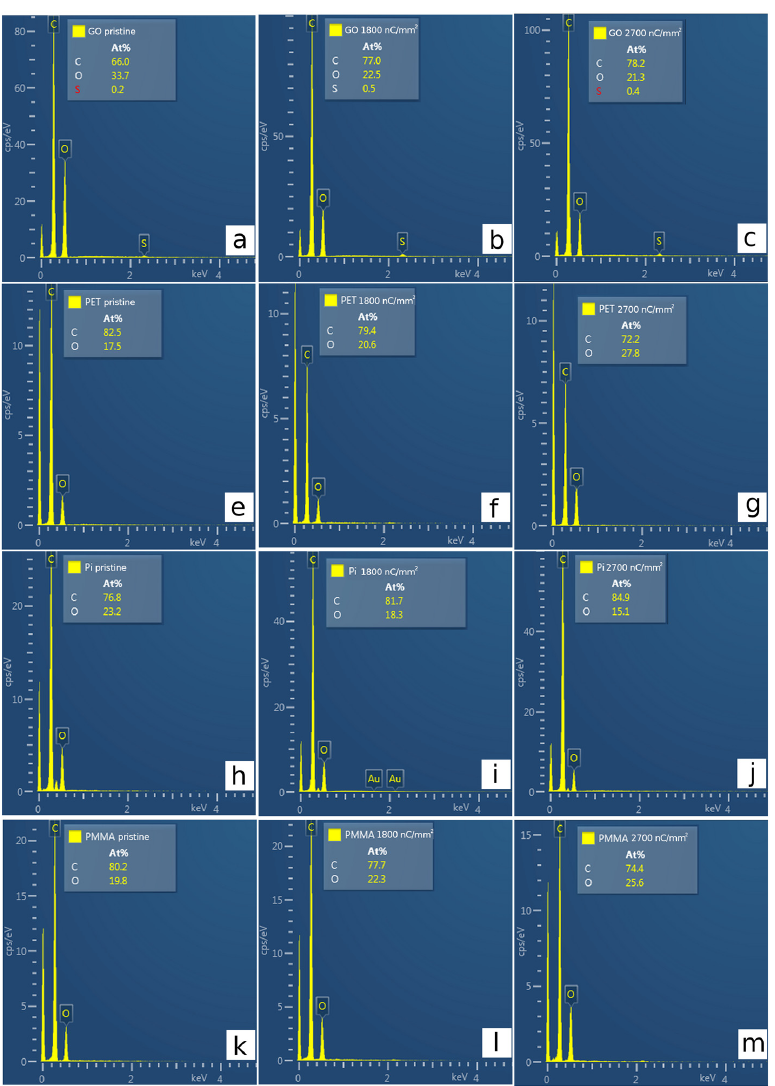
Figure 5. The EDS spectra of unaffected and irradiated foils of GO ( a – c ), PET ( e – g ), PI ( h – j ), and PMMA ( k – m ). The fluence 1800 nC/mm 2 equals 3.75 × 10 14 cm − 2 and 2700 nC/mm 2 equals 5.625 × 10 14 cm − 2